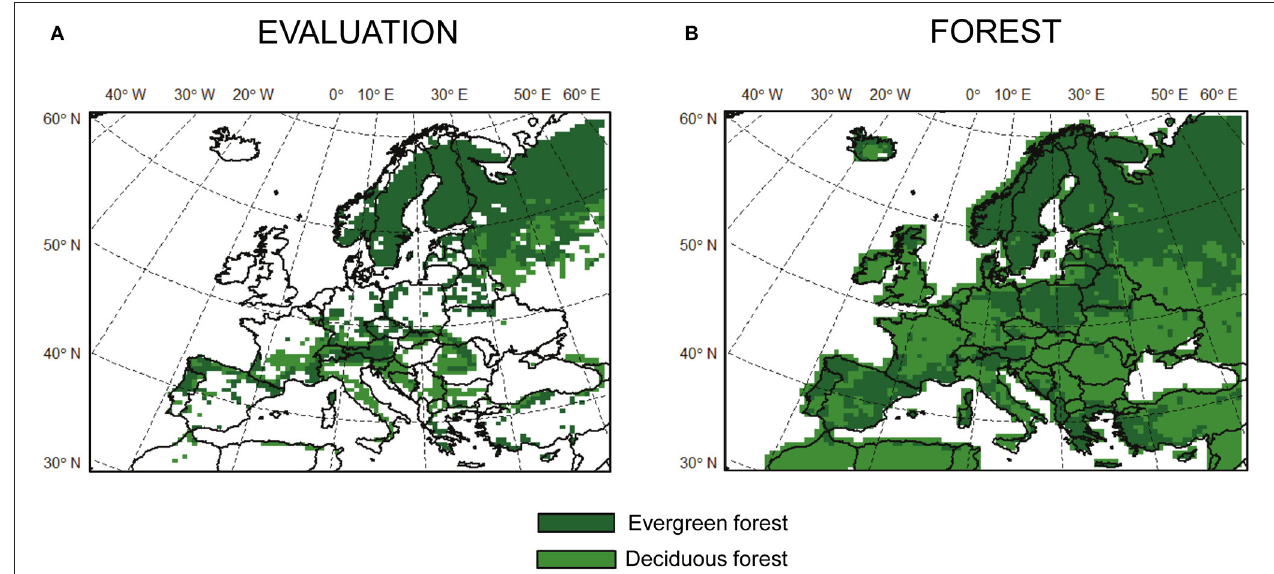
FIGURE 1 | Forest coverage over the EURO-CORDEX domain for the EVALUATION (A) and FOREST (B) simulations. Evergreen (dark green) and deciduous (light green) forest is shown for coverage greater than 50% in a grid